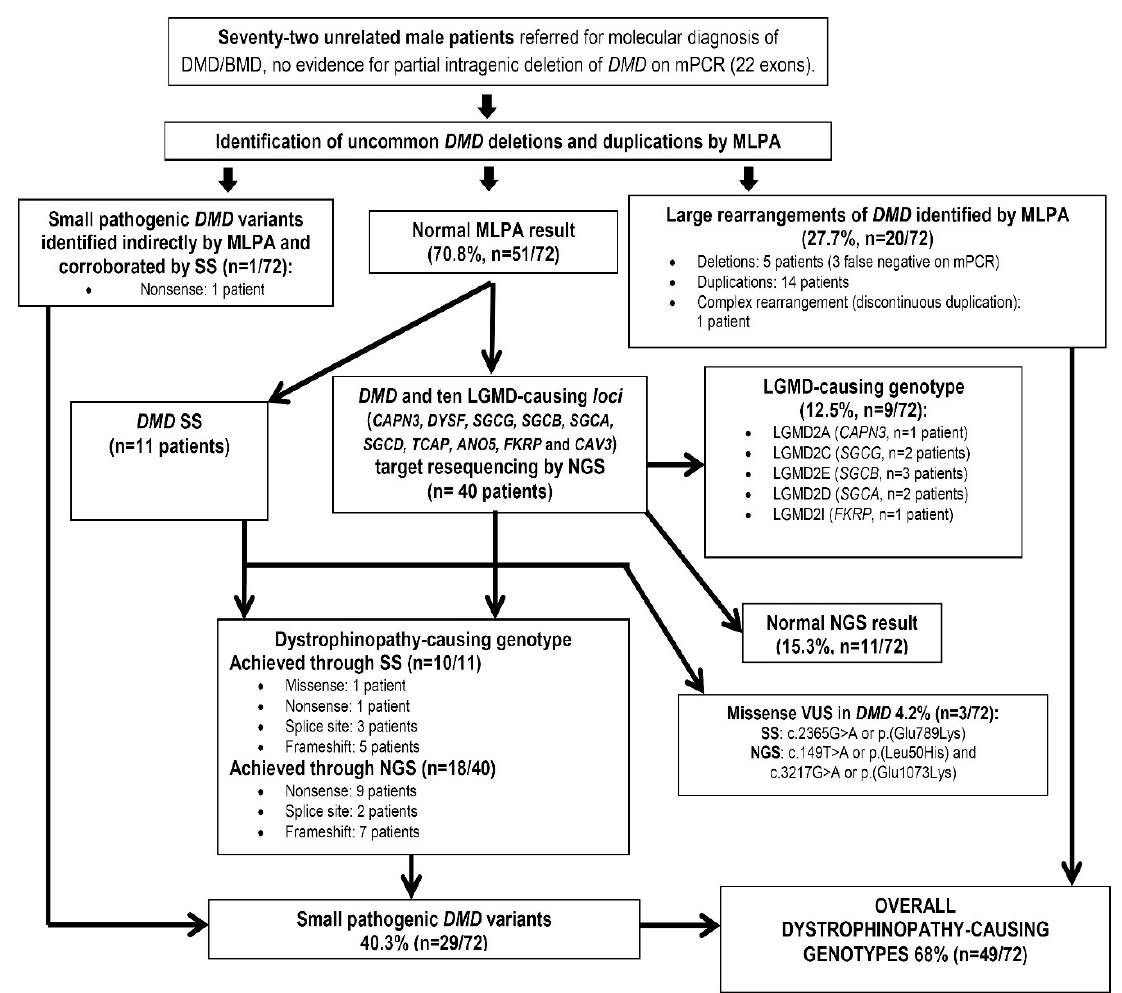
Figure 1. Flow diagram depicting the dystrophinopathy (DMD/BMD) and limb-girdle muscular dystrophy (LGMD) genotypes identified along the different stages of the present study. LGMD2A, 2C, 2E, 2D and 2I, now officially are LGMD R1, R5, R4, R3 and R9 respectively, and according to the LGMD classification proposed by the European Neuromuscular Centre (ENMC) [1]. Abbreviations: MLPA: multiplex ligation-dependent probe amplification; NGS: next-generation sequencing; SS: Sanger sequencing.